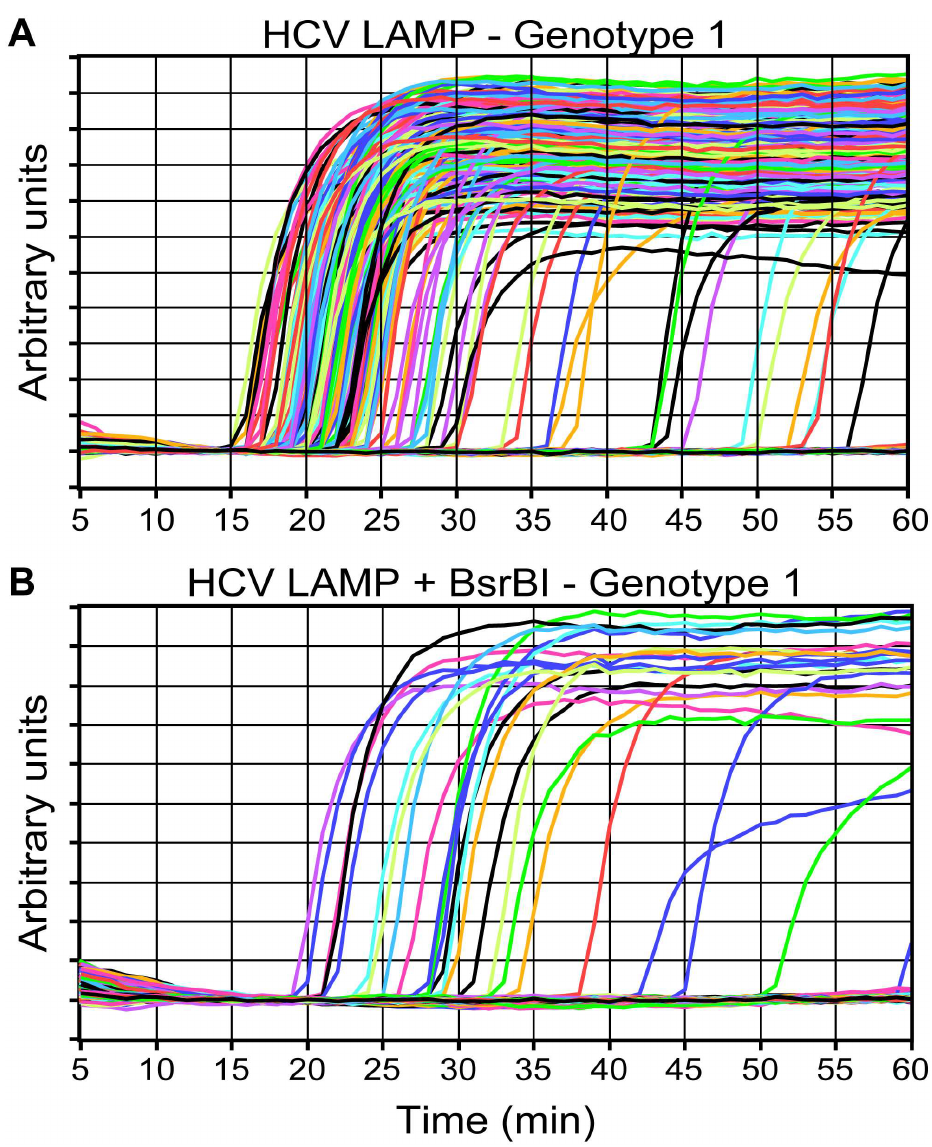
Fig 7. Results of reversetranscription LAMP of HCV RNA reactions in the absence (A) and presence (B) of a competing restriction digestion enzyme, BsrBI. In (A) the reaction is allowedto proceed normally with high reaction efficiency and fast reaction rates. In (B) the reaction efficiency and rate are significantly lower because BsrBI degrades the